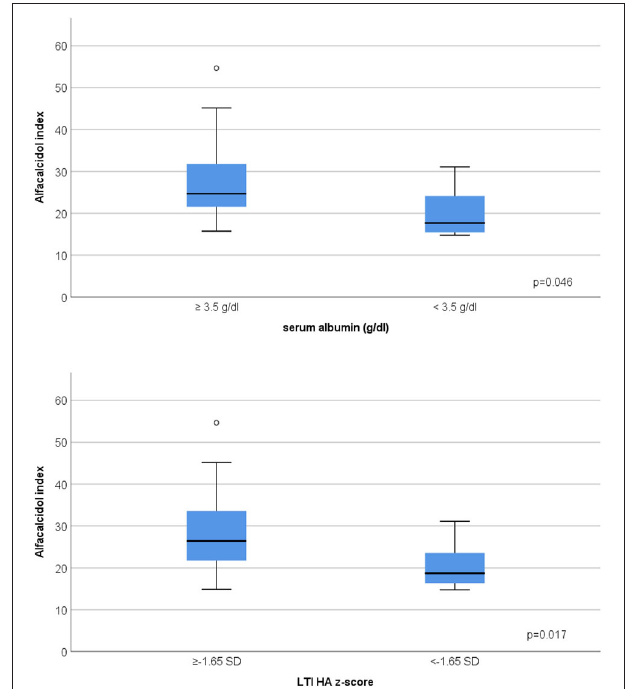
FIGURE 4 | Association between low 6-month mean serum albumin ( < 3.5 g/dl), low lean tissue index adjusted to height-age z-score (LTI-HA) (LTI HA z-score < − 1.65) and alfacalcidol index [(mcg/week per pg/ml of iPTH) × 1,000] in chronic kidney disease (CKD) stage 4–5D